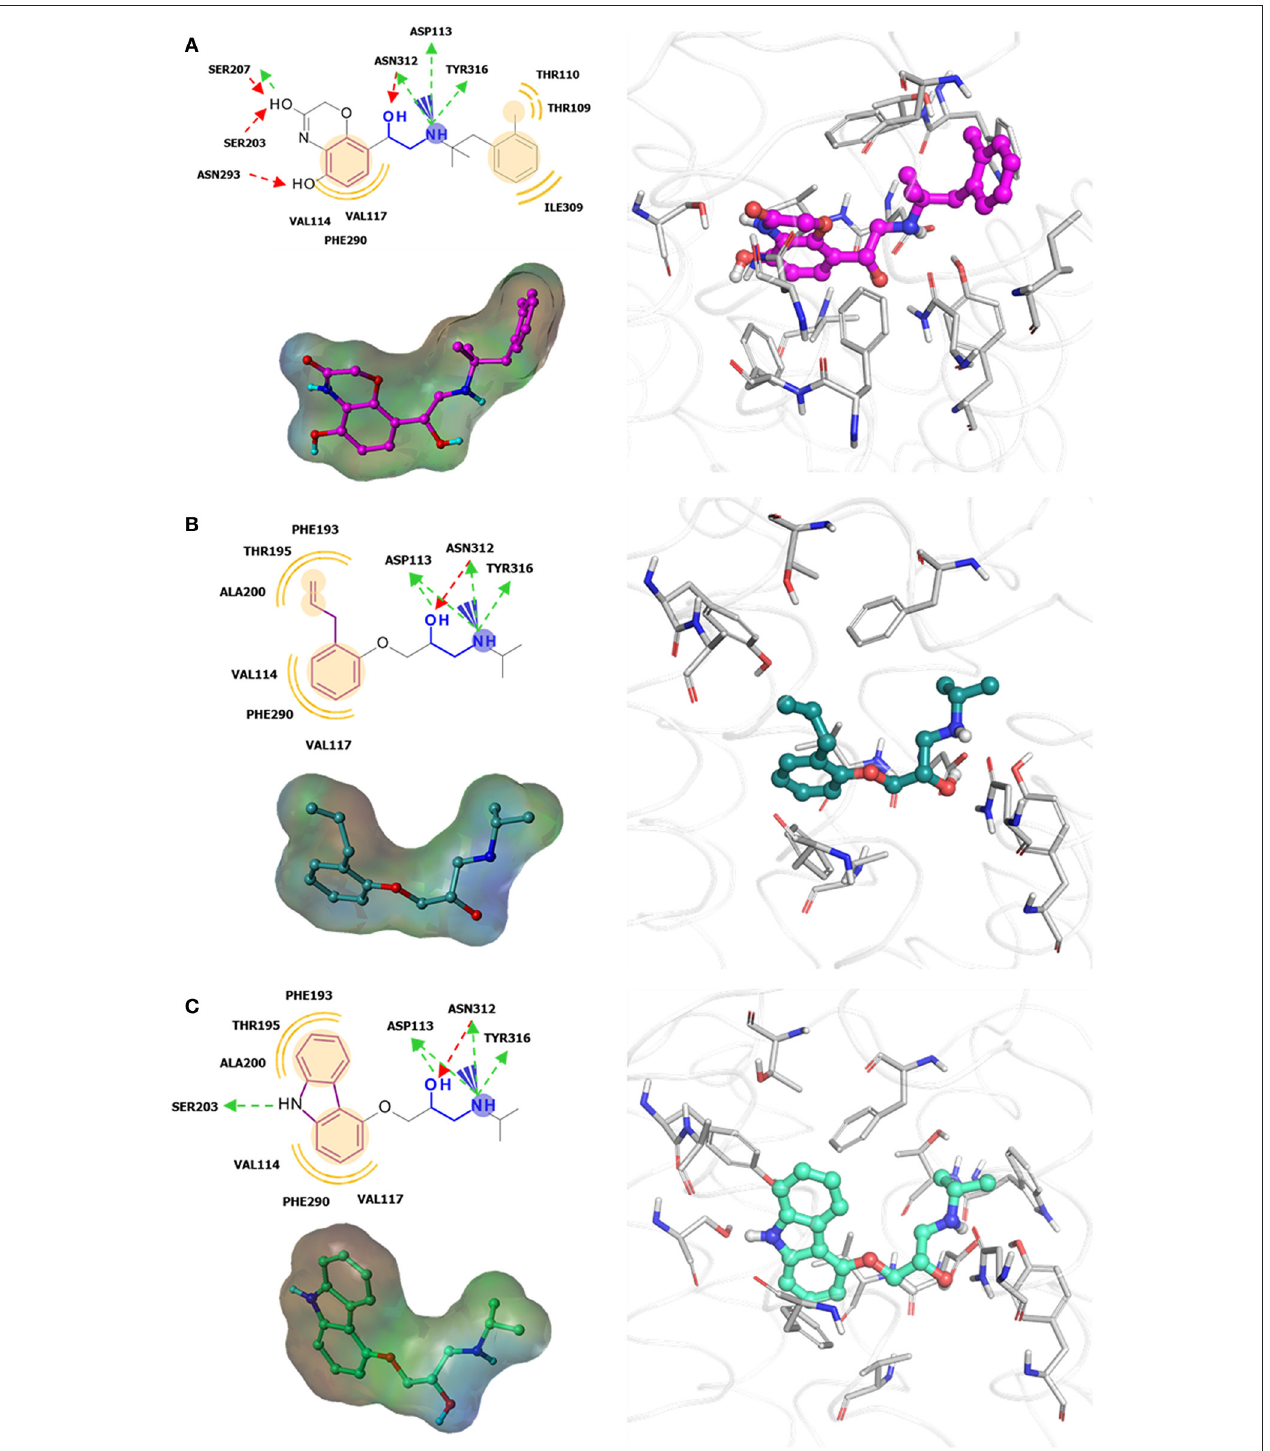
FIGURE 3 | Examples of β 2-adrenergic receptor ( β 2AR) orthosteric ligands with similar structures but possess different activities. (A) BI167,107 acts an agonist (PDB ID: 4LDE) (Ring et al., 2013), (B) alprenolol acts an antagonist (PDB ID: 3NYA) (Wacker et al., 2010), and (C) carazolol acts as an inverse agonist (PDB ID: 2RH1) (Cherezov et al.,